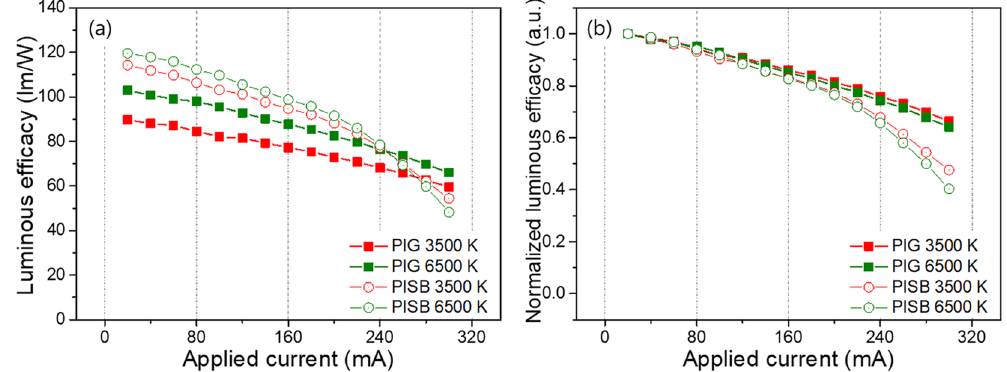
Figure 7. ( a ) LE (lm/W) and ( b ) normalized LE of the PIG- and PISB-based on-chip WLEDs as a function of the applied current, with a range between 20 mA and 300